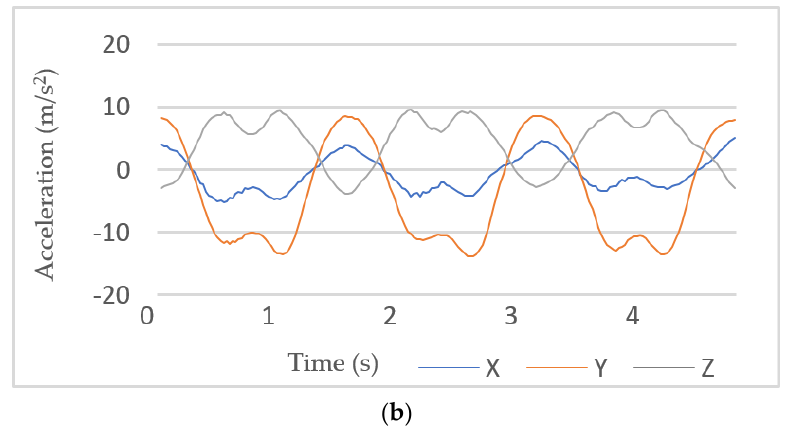
Figure 5. Preprocessing of raw sensor data: ( a ) before preprocessing; and ( b ) after MAF.